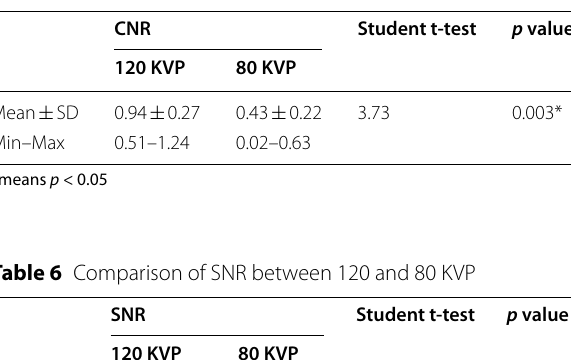
Table 5 Comparison of CNR between 120 and 80 KVP